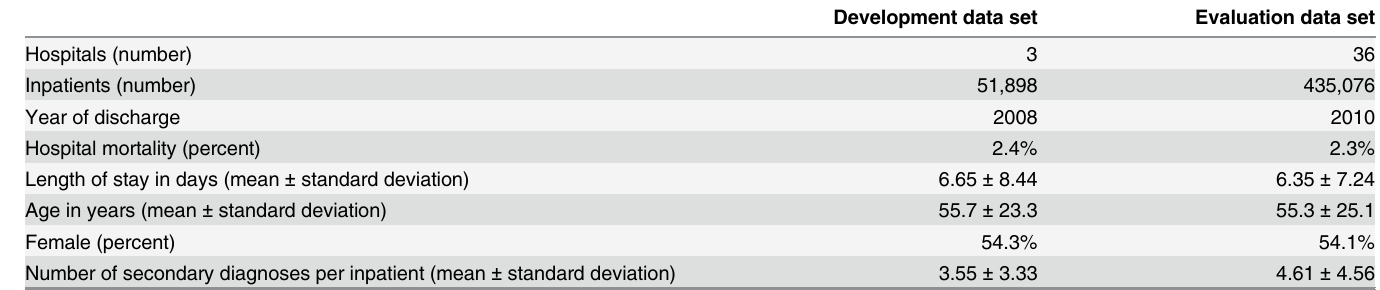
Table 1. Description of the